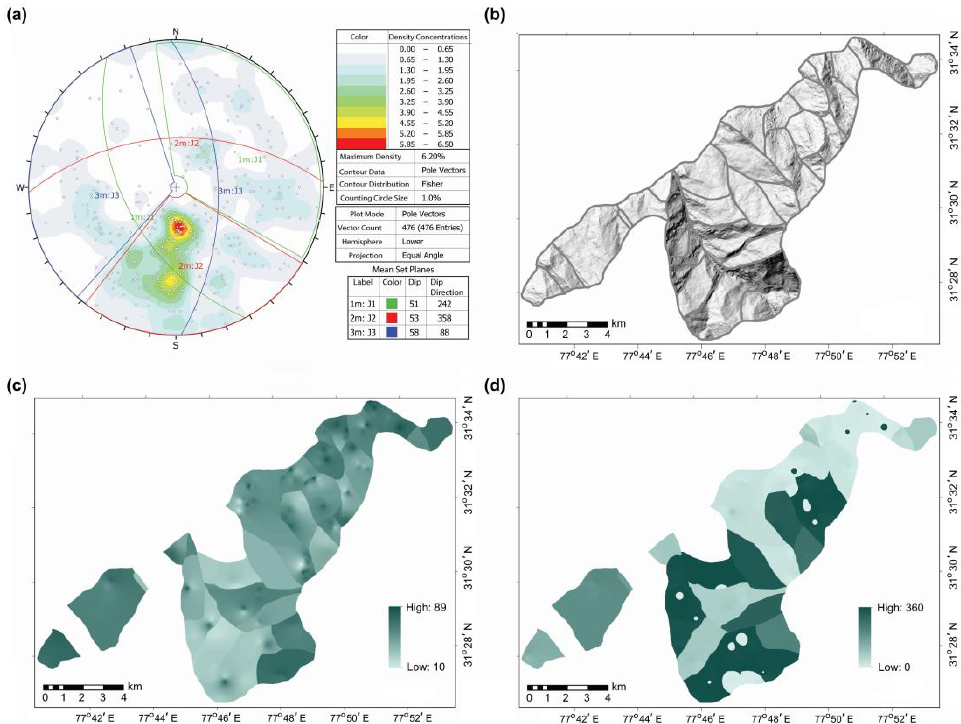
Figure 6. ( a ) Pole plot of all the discontinuities on a stereographic net showing the major orientation of discontinuity sets 1, 2 and 3. ( b ) representation of structurally homogenous zones within the small grey polygon boundaries draped over the hill shade layer derived from DEM. ( c ) Interpolated dip map of joint-1 in the area (IDW with barriers of joint zones and structural defects) ( d ) Interpolated dip direction map of joint-1 in the area (IDW interpolation with barriers of joint zones and structural defects).